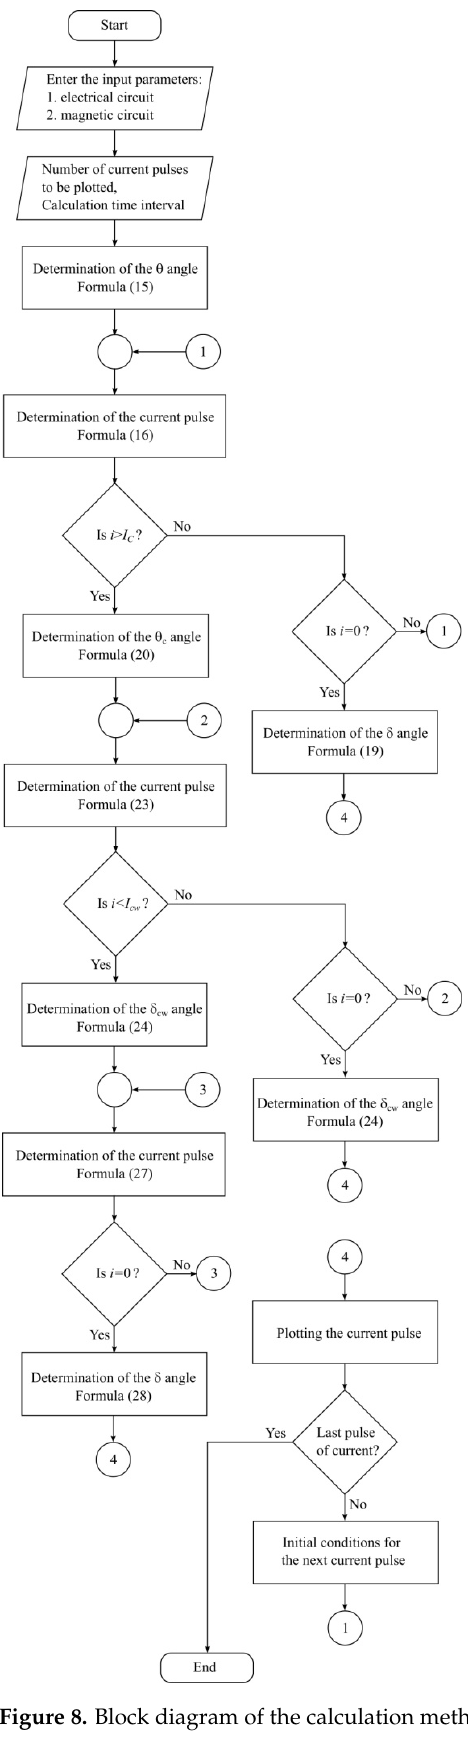
Figure 8. Block diagram of the calculation method.